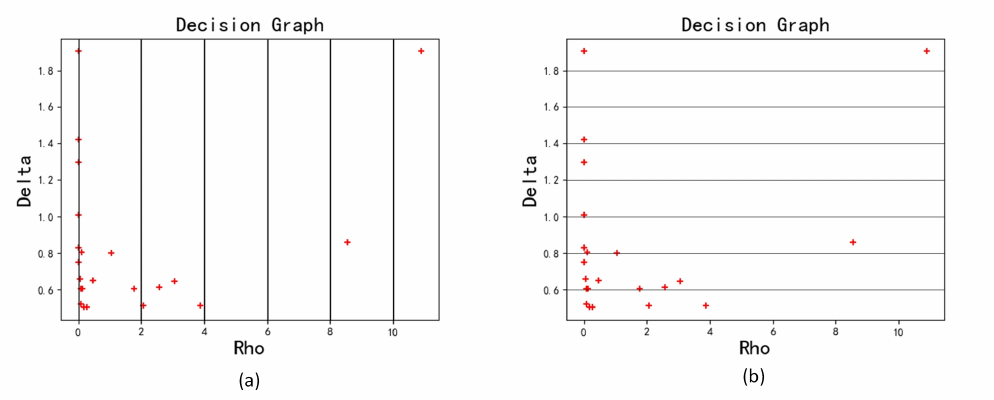
Figure 1. ρ and δ division of randomly generated dataset. ( a ) ρ division; ( b ) δ